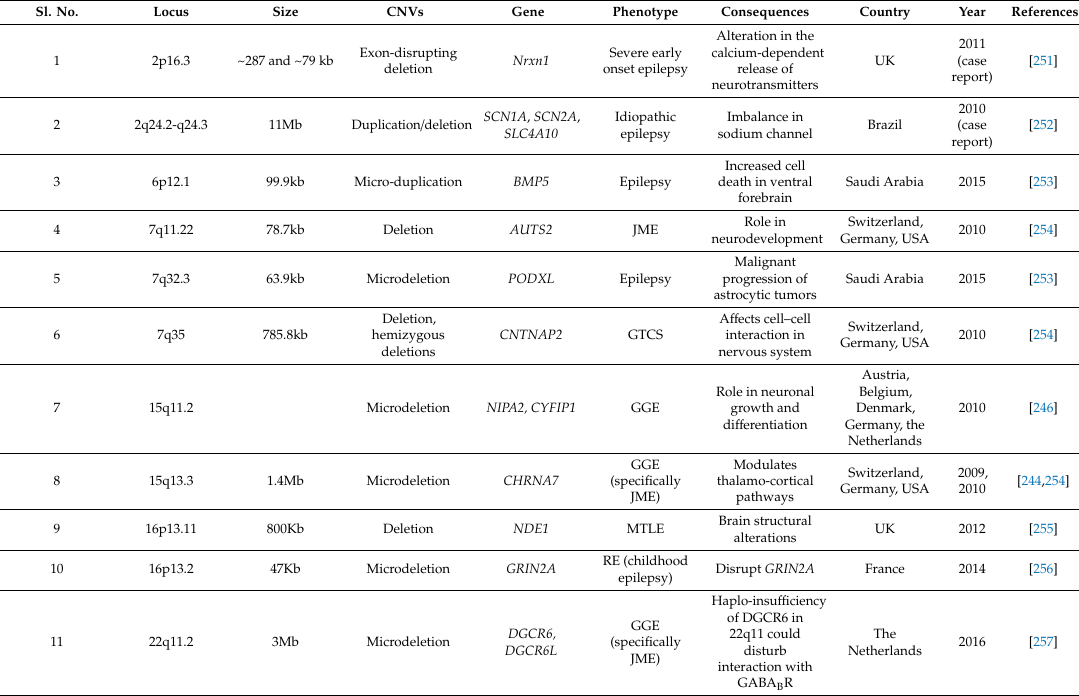
Table 2. Di ff erent copy number variants (CNVs) associated with